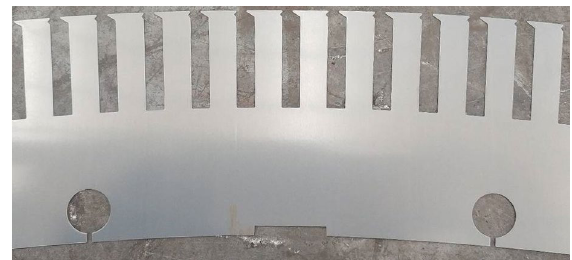
Figure 3. Configuration of the stator slot.